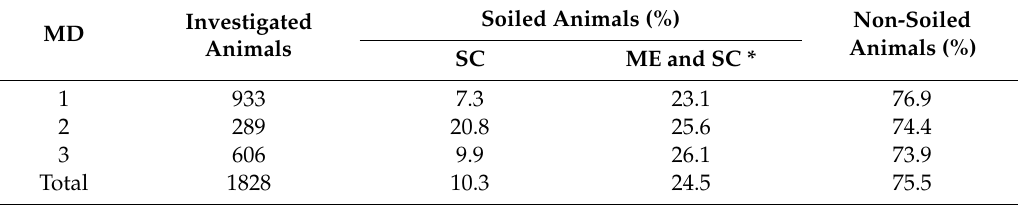
Table 2. The number of investigated and soiled animals (% of investigated animals) of the three measurement days (MD) (fattening day 32, 61, and 109) and in total for the entire period.